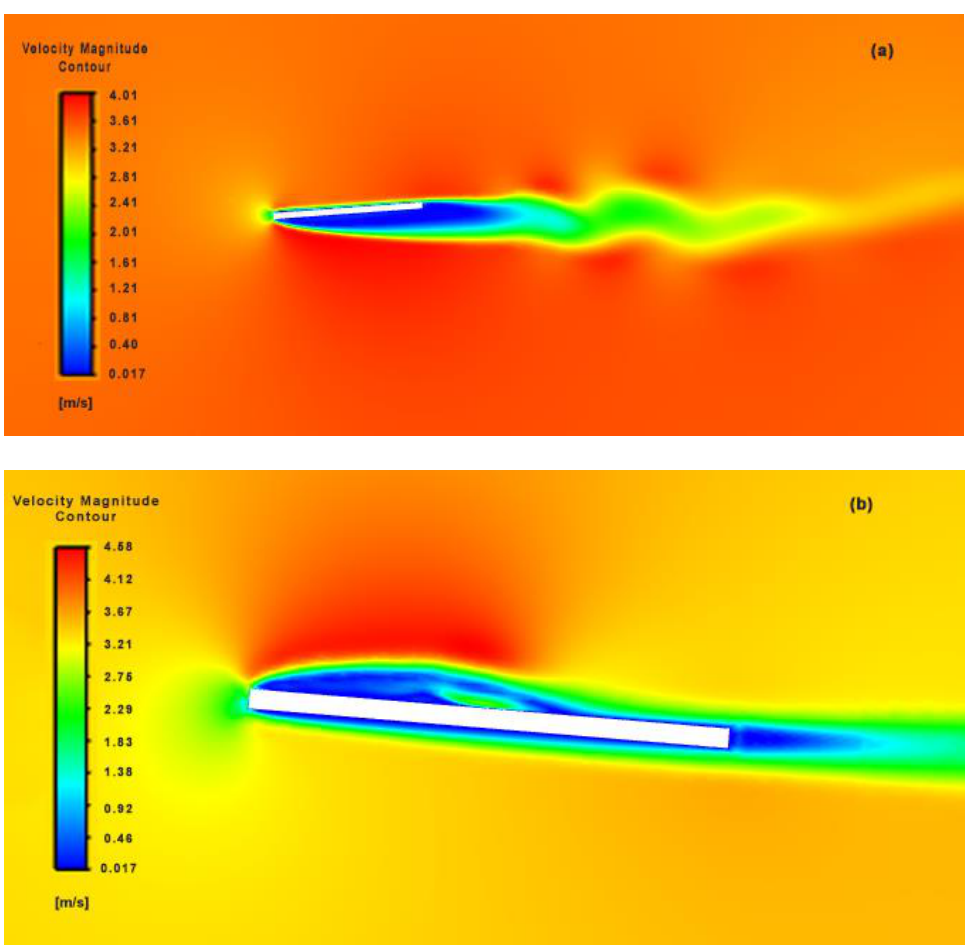
Figure 18. Symmetrical ( a ) downstroke and ( b ) upstroke velocity magnitude contours over flapping flat plate at 150th and 314th time frame respectively.